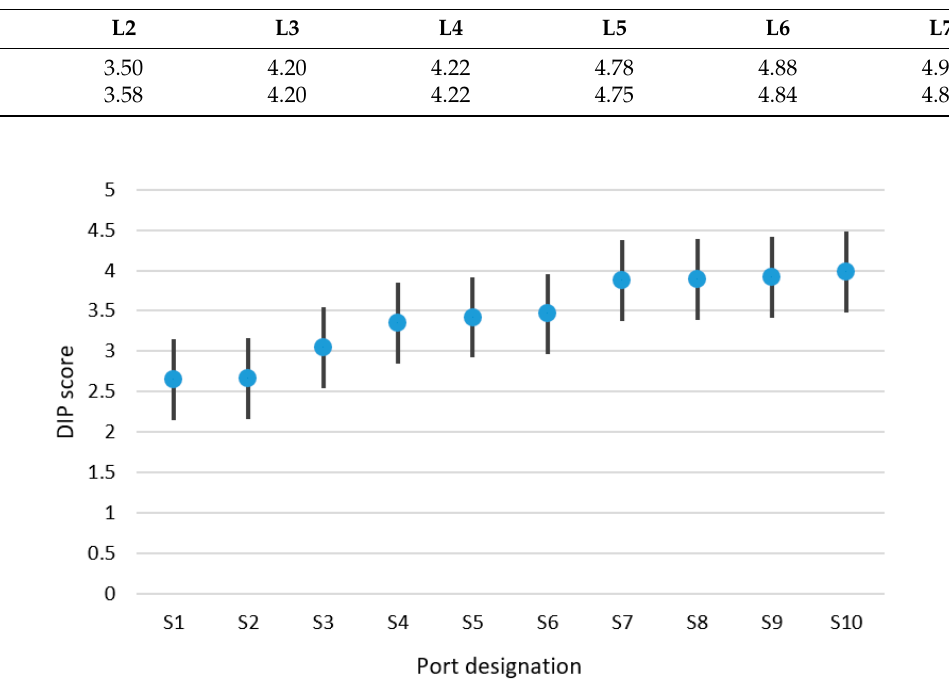
Table 5. DIP score values calculated for medium-sized ports.